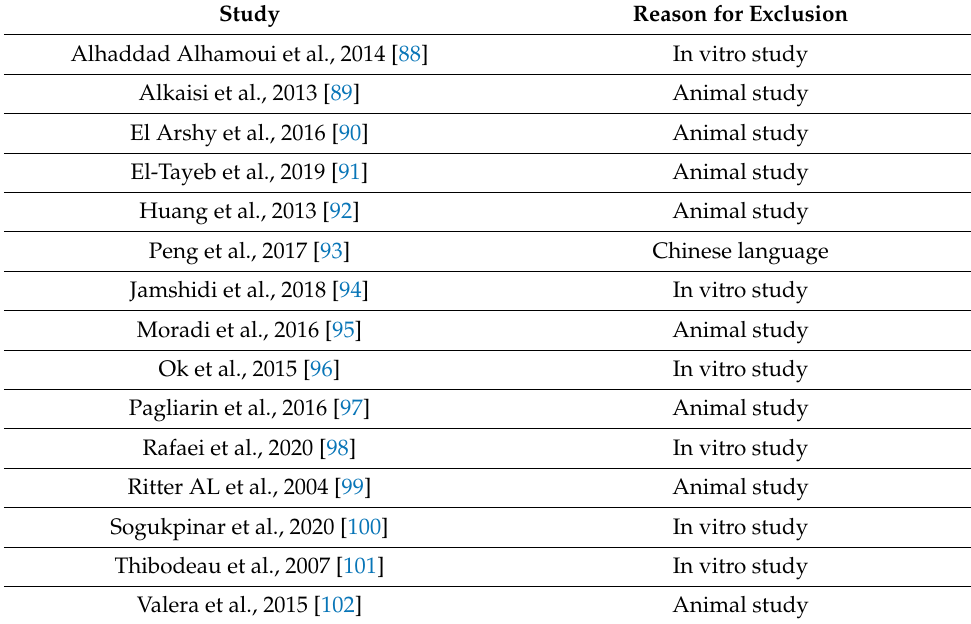
Table A1. List of excluded studies after reading the full